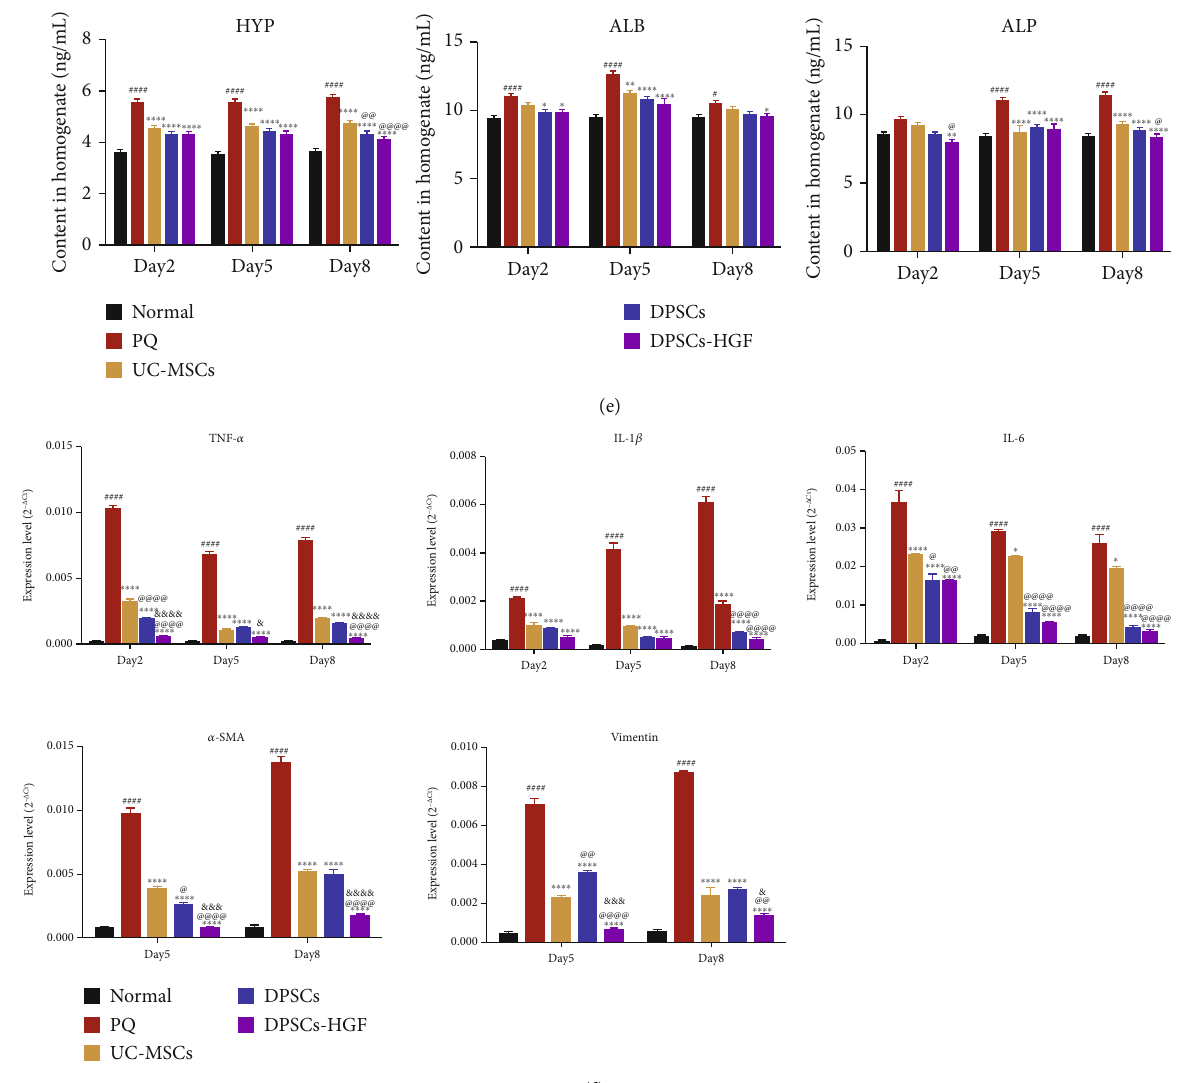
Figure 6: DPSCs-HGF transplantation protects against PQ-induced lung injury. (a) Survival rates were analyzed on day 28. (b) H&E staining and Masson staining were performed on lung sections. The nucleus was stained red by H&E, and collagen fi bers were stained blue by Masson ’ s trichrome. (c) The in fl ammation grade was analyzed. ANOVA followed by Dunn ’ s multiple comparisons test was used to evaluate these data. (d) The percentage of the collagen fi ber area was analyzed by Image-Pro Plus 6.0 software, and 10 random visual fi elds at 400x magni fi cation were selected from each slice. (e) The expression of HYP, ALB, and ALP in BALF was detected by ELISA. (f) The expression of in fl ammation-related and fi brosis-related factors, including TNF- α , IL-1 β , IL-6, α -SMA, and vimentin, was analyzed by qPCR. Each experiment was performed in triplicate; the data are shown as the means ± SEM . ANOVA followed by Tukey ’ s multiple comparisons test was used to evaluate these data. # P < 0 : 05 , ### P < 0 : 001 , and #### P < 0 : 0001 vs. normal; ∗ P < 0 : 05 , ∗∗ P < 0 : 01 , and ∗∗∗∗ P < 0 : 0001 vs. PQ; @ P < 0 : 05 , @@ P < 0 : 01 , and @@@@ P < 0 : 0001 vs. UC-MSCs; & P < 0 : 05 , &&& P < 0 : 001 , and &&&& P < 0 : 0001 vs. DPSCs. PQ: paraquat; H&E: hematoxylin and eosin; HYP: hydroxyproline; ALB: albumin; ALP: alkaline phosphatase; α -SMA: α - smooth muscle